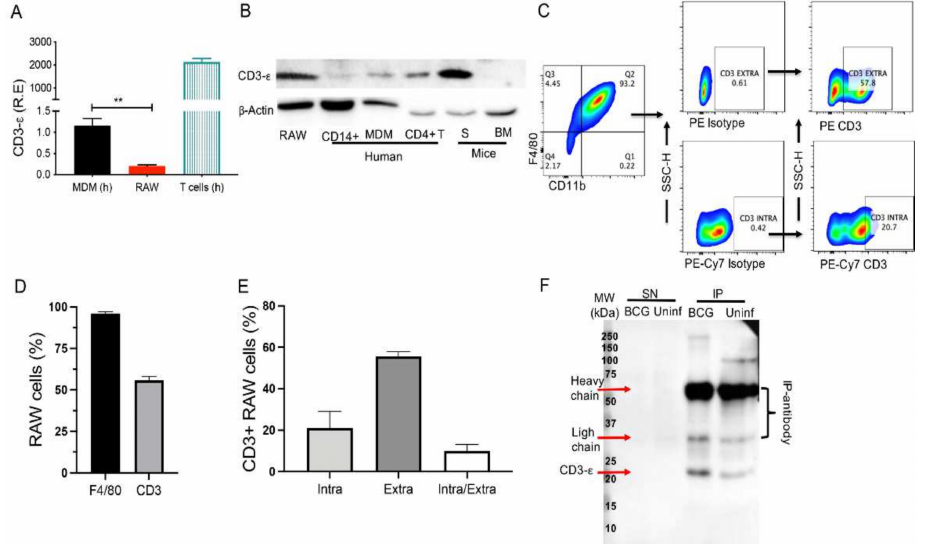
Figure 1. CD3 is expressed on RAW cells. ( A ) RNA of human T cells and monocyte-derived macrophages (MDM) and RAW cells were obtained to assess relative expression (R.E) of CD3- Σ by qPCR. Graphic shows murine and human data; however, each one was normalized to its corresponding endogenous control. ( B ) Immunoblot analysis of CD3- Σ identification in RAW cells, human monocytes (CD14+), MDM, human CD4+ T cells, murine splenocytes (S), and murine bone marrow cells (BM). β -actin was used as a loading control. ( C ) Representative dot plot showing analysis strategy to identify intra- and extracellular CD3 expression in RAW cells by flow cytometry. ( D ) Frequency of RAW cells positive for F4/80 and CD3- Σ obtained by cell surface staining and evaluated by flow cytometry. ( E ) Frequency of RAW cells positive for intracellular or extracellular CD3 or both. ( F ) Representative immunoblot analysis of samples immunoprecipitated with a system of protein G coupled to magnetic beads and monoclonal anti-CD3. n = 5 independent experiments (for flow cytometry), n = 3 independent experiments by duplicate (for qPCR), ( B , F ), a representative image of 3 independent experiments. Bars represent the mean of means ± SEM (to ( A )) or the mean value ± SD (to ( D , E )). One-way ANOVA followed by the Bonferroni test were used for qPCR analyses. ** p <